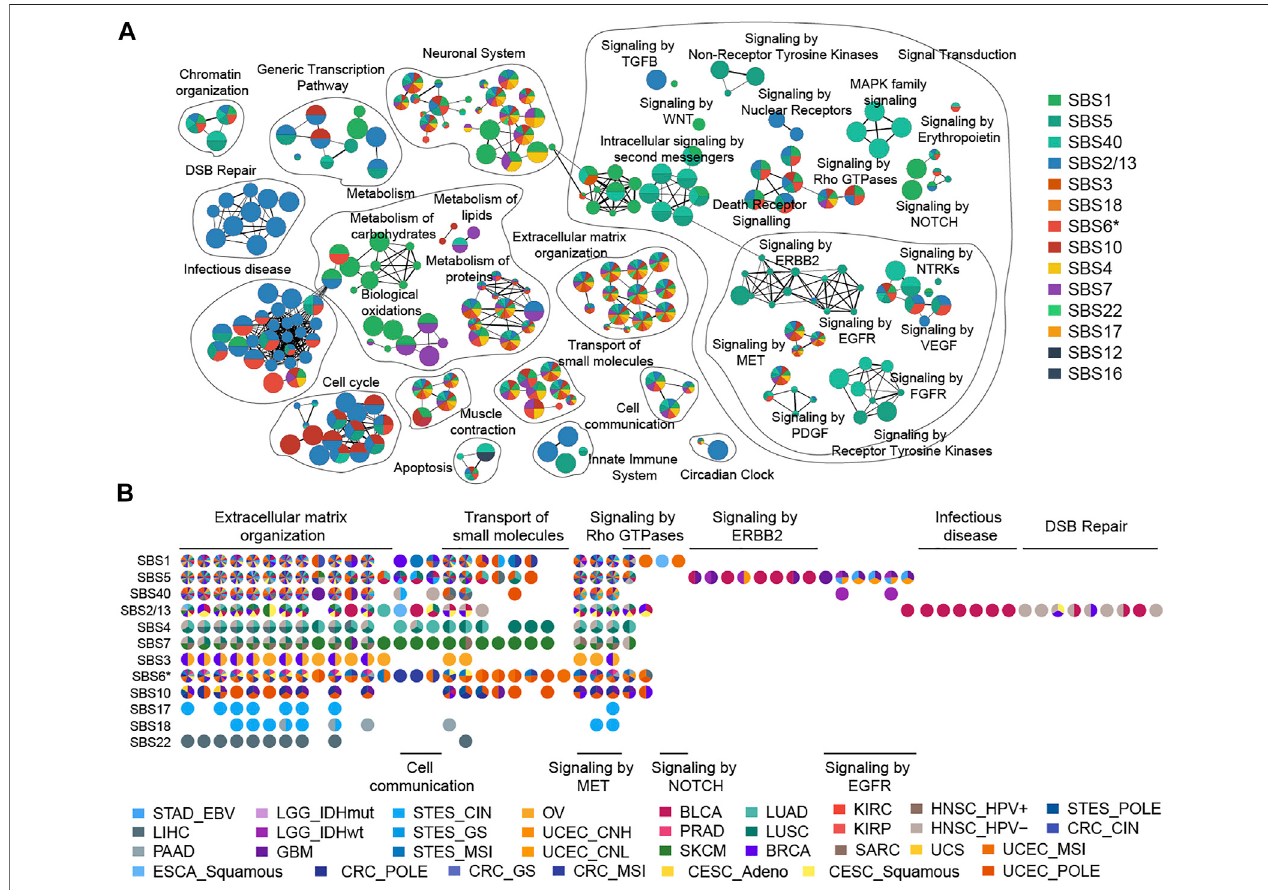
FIGURE 4 | Enrichment map of pathways affected by mutational processes. (A) Nodes in the network represent pathways and are colored by associated mutational processes. The node size indicates the number of genes in a pathway. Similar pathways with many common genes are connected and named according to prior knowledge. (B) Cancer type evidence of various mutational processes affecting pathways. Nodes in the matrix are fi lled by cancer-type evidence.